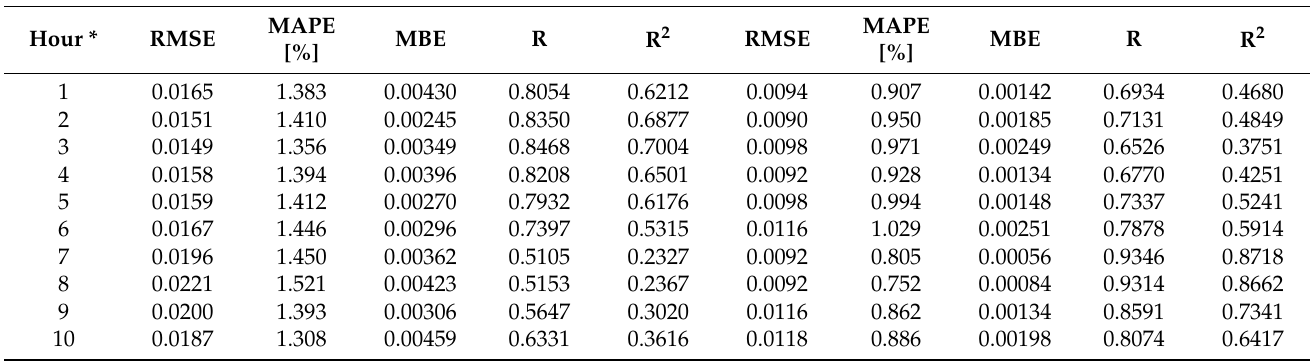
Table A1. Forecast accuracy metrics of the MLP + LSTM Ensemble Method for particular times of the